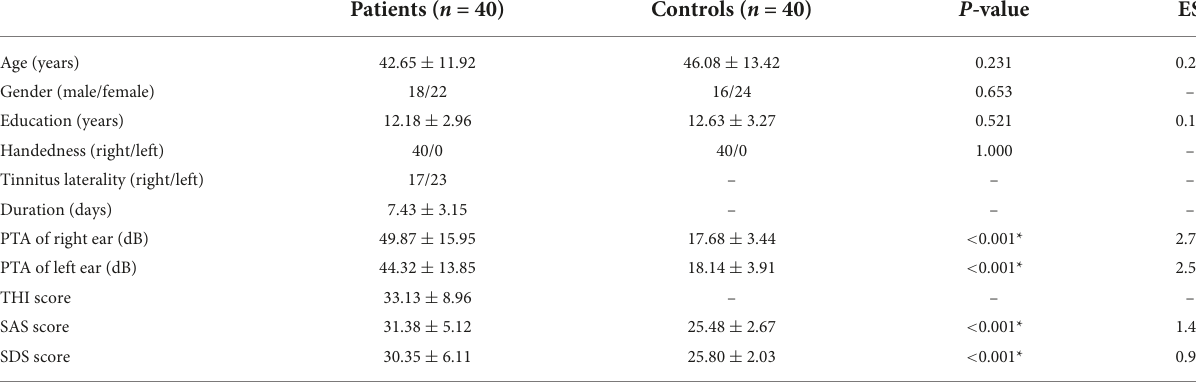
TABLE 1 Demographic and clinical characteristics of